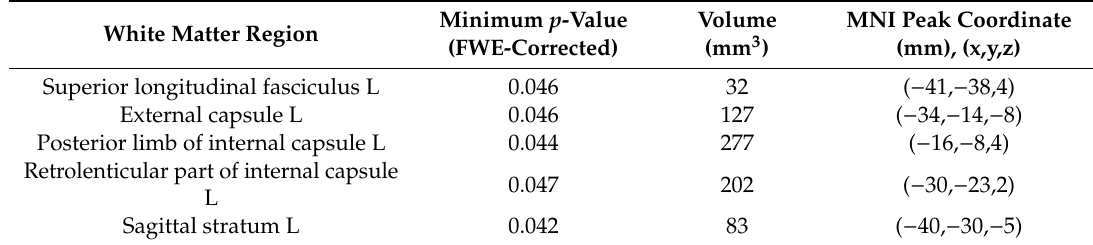
FWE = Family-wise error; L = left; R = right. The column volume represents the volume from the atlas region with significant results. No regions with a volume equal or lower than 30 mm 3 were included in this